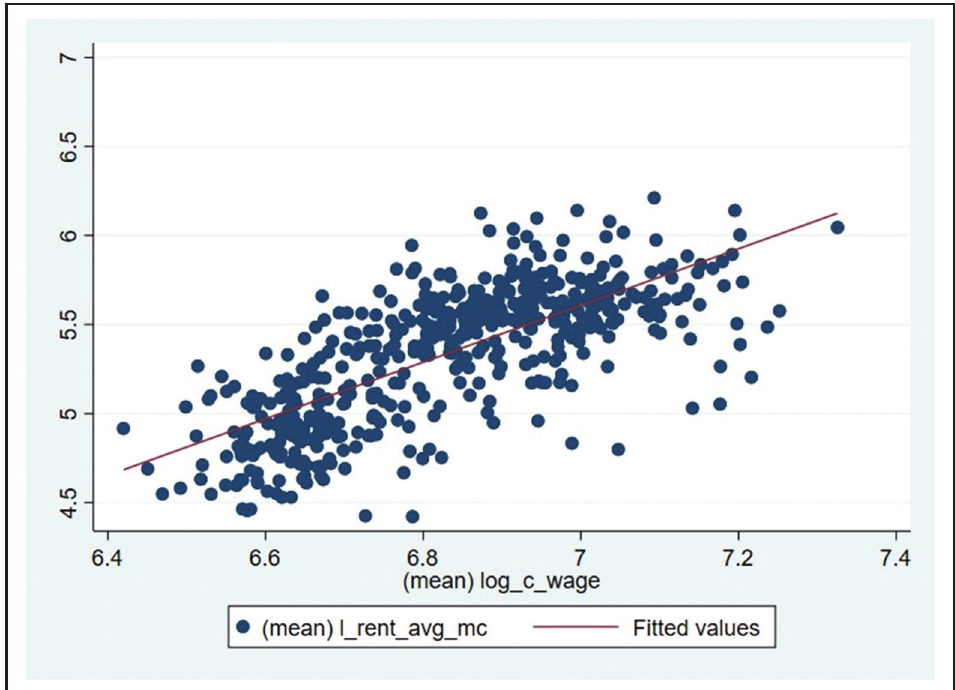
Price instrument (average wages in contiguous microregiões ) and prices ( average municipality rents in microregião ).